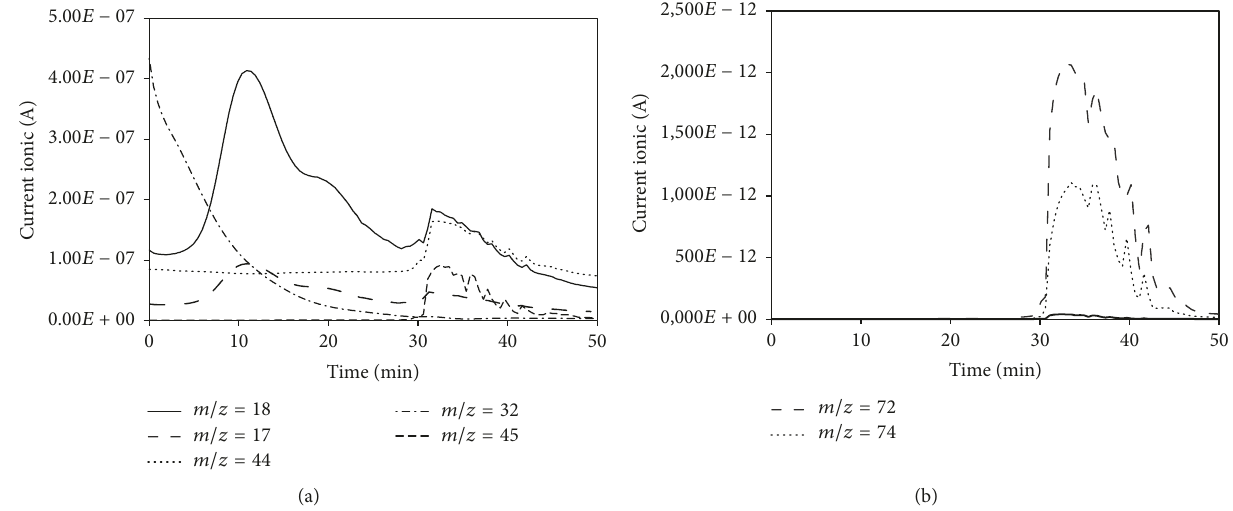
Figure 6: TG-MS lactic acid isothermal at 573 K during the time. (a): 𝑚/𝑧 = 17 , 18, 32, 44, and 45. (b): 𝑚/𝑧 = 72 and 74. The solid line in (b) is a type of noise from the